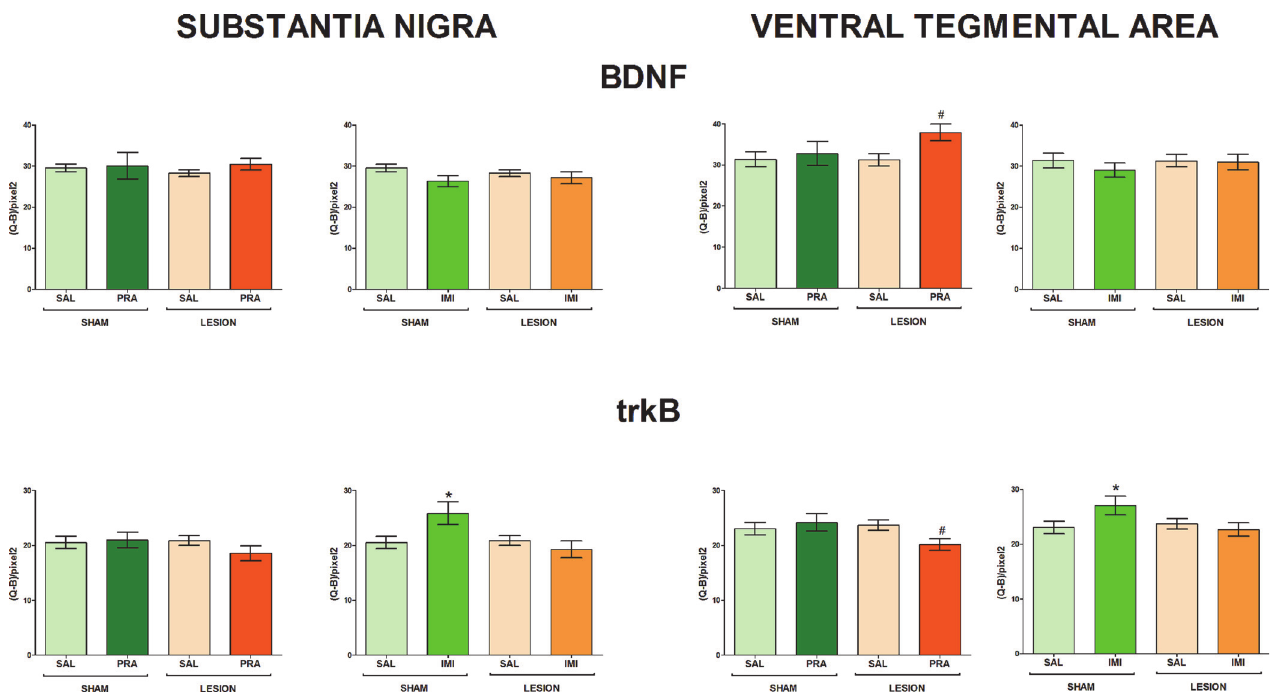
Fig 8. The influence of 6-OHDA, pramipexole and imipramine on BDNF and trkB mRNAs in mesencephalic structures. n = 5 – 10 (substantia nigra), n = 7 – 10 (ventral tegmental area). For further explanations see Figs. 1 and